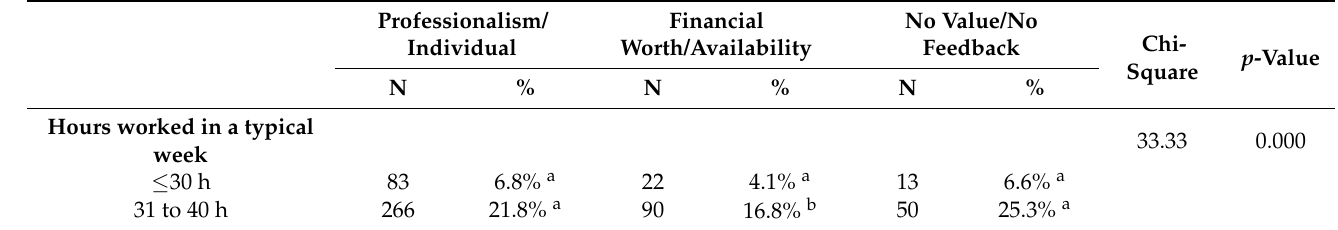
Table 3. Work-related